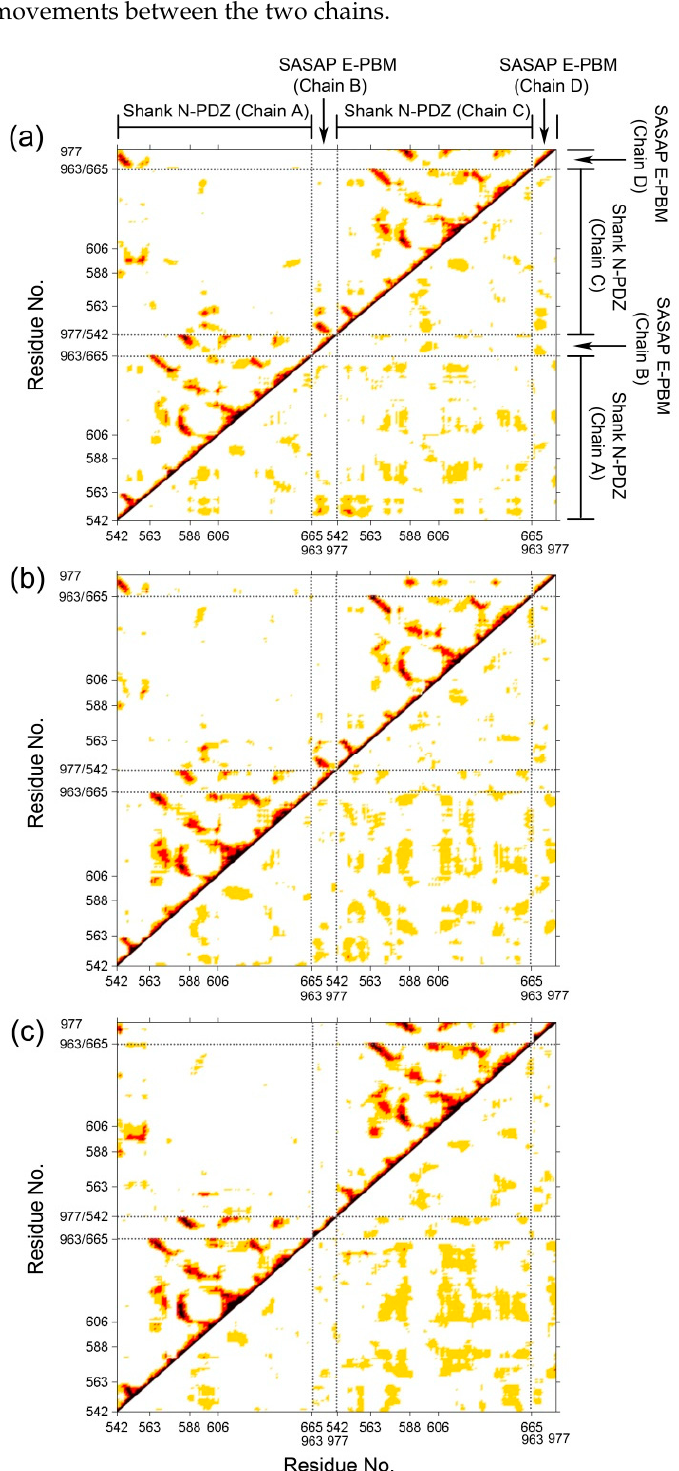
Figure 4. Dynamical cross-correlated map (DCCM) of WT ( a ), M4P ( b ) and M5P ( c ) systems. Deeper color indicates more correlated or anti-correlated. Both x and y axes are residue indices of proteins.